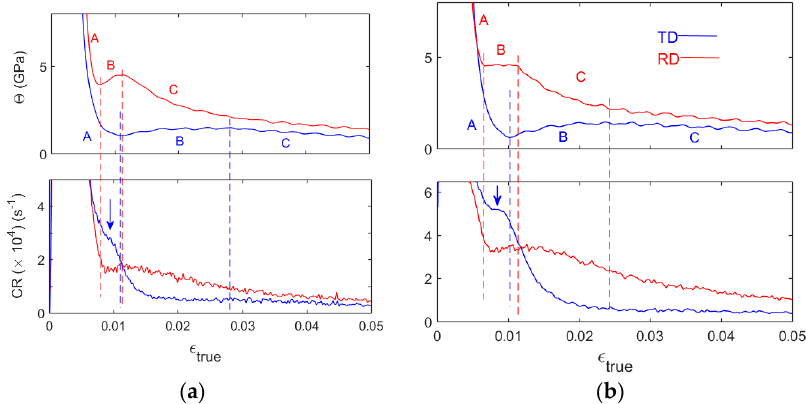
Figure 4. ( a ) Magnification of Figure 3b,c and ( b ) similar plots for two samples deformed at 2 × 10 − 3 s − 1